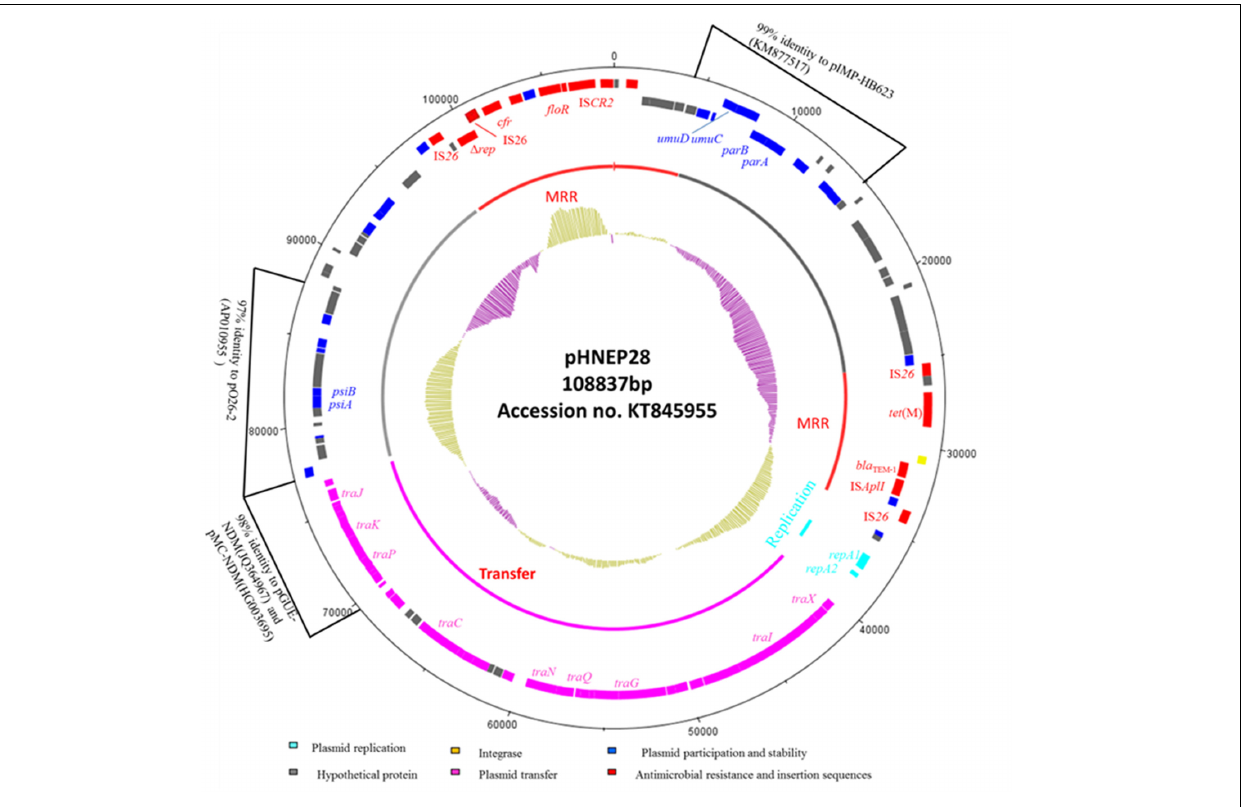
FIGURE 1 | Circular map of the IncFII:43 plasmid pHNEP28. The most external circle represents the size of complete plasmid circle in bp. The clockwise orientation open reading frames (ORFs) are presented first and then in the counterclockwise orientation. The inner circle indicates the functional regions. The G+C plot is displayed in the inner circle, with yellow indicating > 50% and purple indicating <